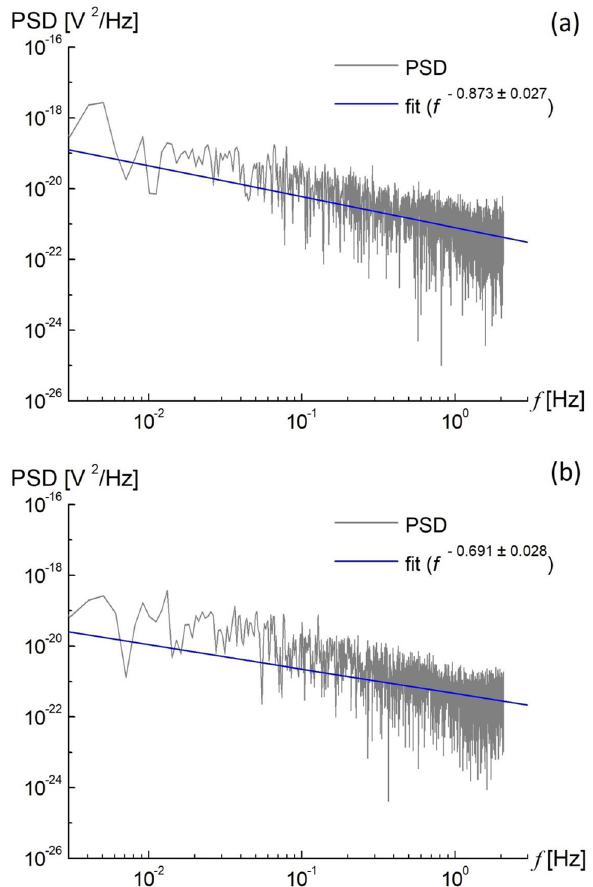
Figure 7. Power spectral density (PSD) as a function of the frequency ( f ) of the extracellular ionic fluxes of hyacinth at ( a ) 22.95(5) °C and ( b ) 20.20(5) °C. The calculated linear descent of the spectral exponent ( β ) equaled ( a ) 0.873(27) and ( b ) 0.691(28) and represented ( a ) pink and ( b ) pink/white noise, respectively. Note that the linear, logarithmic curve ( a ) signals the relationship with the coherent dynamics, whereas the spectral exponent corresponds to the fractal dimension of the system dynamic.